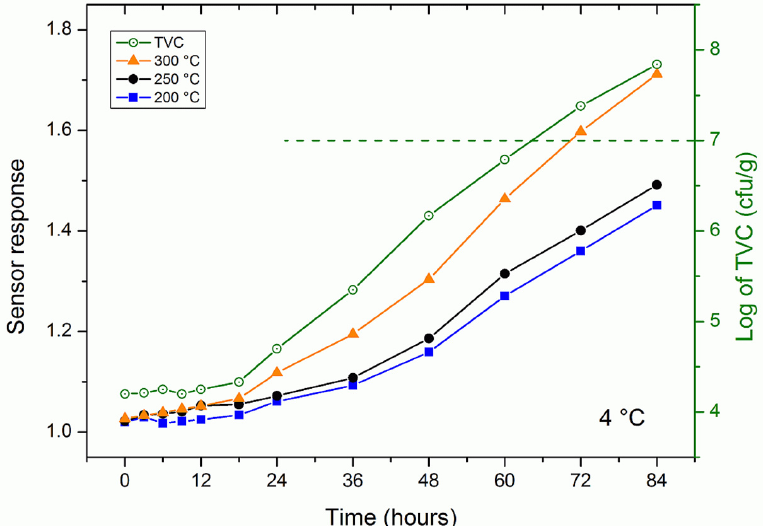
Figure 5. Sensor response (solid symbols, left scale) and bacterial population (green open circles, right scale) in fresh trout fish kept at 4 °C over a period of 60 h.